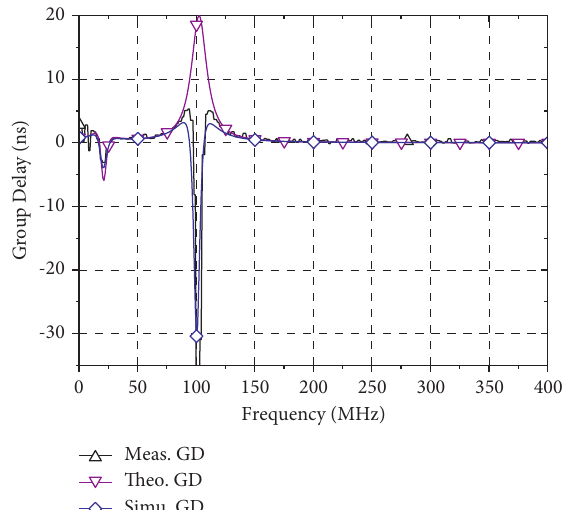
Figure 21: Band-pass negative group delay of the band-stop filter.